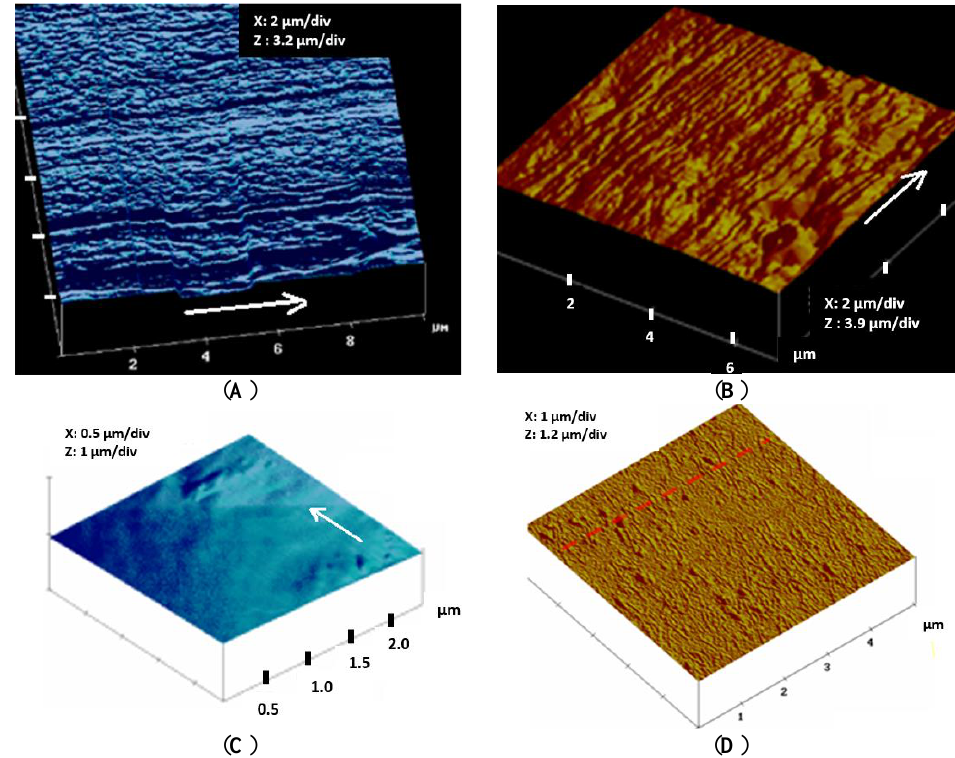
Figure 5. Typical topographical image obtained by Atomic Force Microscopy (in Tapping Mode) of PLLA filaments of diameter 30, 100 and 230 µm compared to a PLA film. White arrows indicate fiber length direction. ( A ) PLLA fiber (diamter100 µm); Ra = 80 nm; Rq = 120 nm; ( B ) PLLA fiber (diameter 230 µm); Ra =52 nm; Rq =70 nm; ( C ) PLLA fiber (30 µm); Rq = 3 nm; Ra =6 nm; ( D ) PLLA film; Rq =13 nm; Ra =2 nm.